Question: What does this figure show? Answer in one sentence.
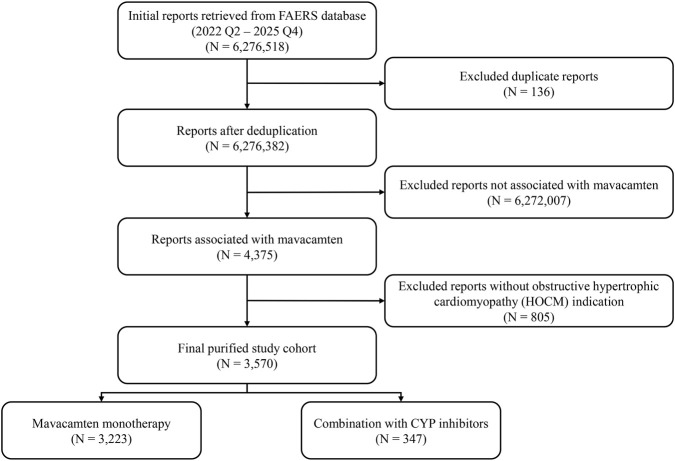
Answer: Study selection flowchart. Flowchart detailing the data extraction, deduplication, and cohort identification process from the FAERS database (Q2 2022 to Q4 2025). A final cohort of 3,570 mavacamten-treated HOCM reports was identified and subsequently stratified into two sub-cohorts: the mavacamten monotherapy group (n = 3,223) and the concomitant CYP inhibitor therapy group (n = 347). Abbreviations: FAERS, FDA Adverse Event Reporting System; HOCM, obstructive hypertrophic cardiomyopathy; CYP, cytochrome P450.